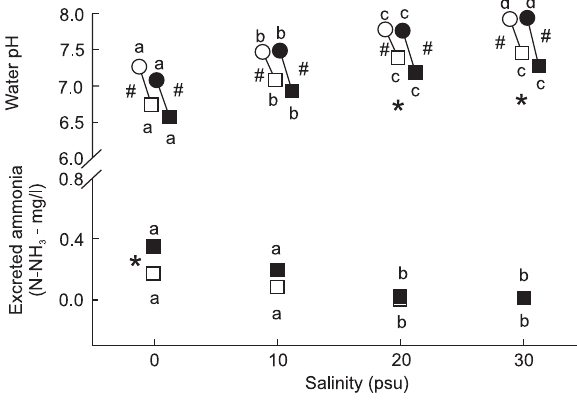
Figure 3. Initial (circles) and final (squares) pH and excreted am- monia (N-NH ) in water of M. acanthurus exposed to salinities 0 3 (control), 10, 20, and 30 psu for 4 (white symbols) and 8 hours (black symbols). Different letters mean differences between salinities within each time of exposure. * = value for 4 hours is different from value for 8 hours within a same salinity, # = initial and final values of water pH are